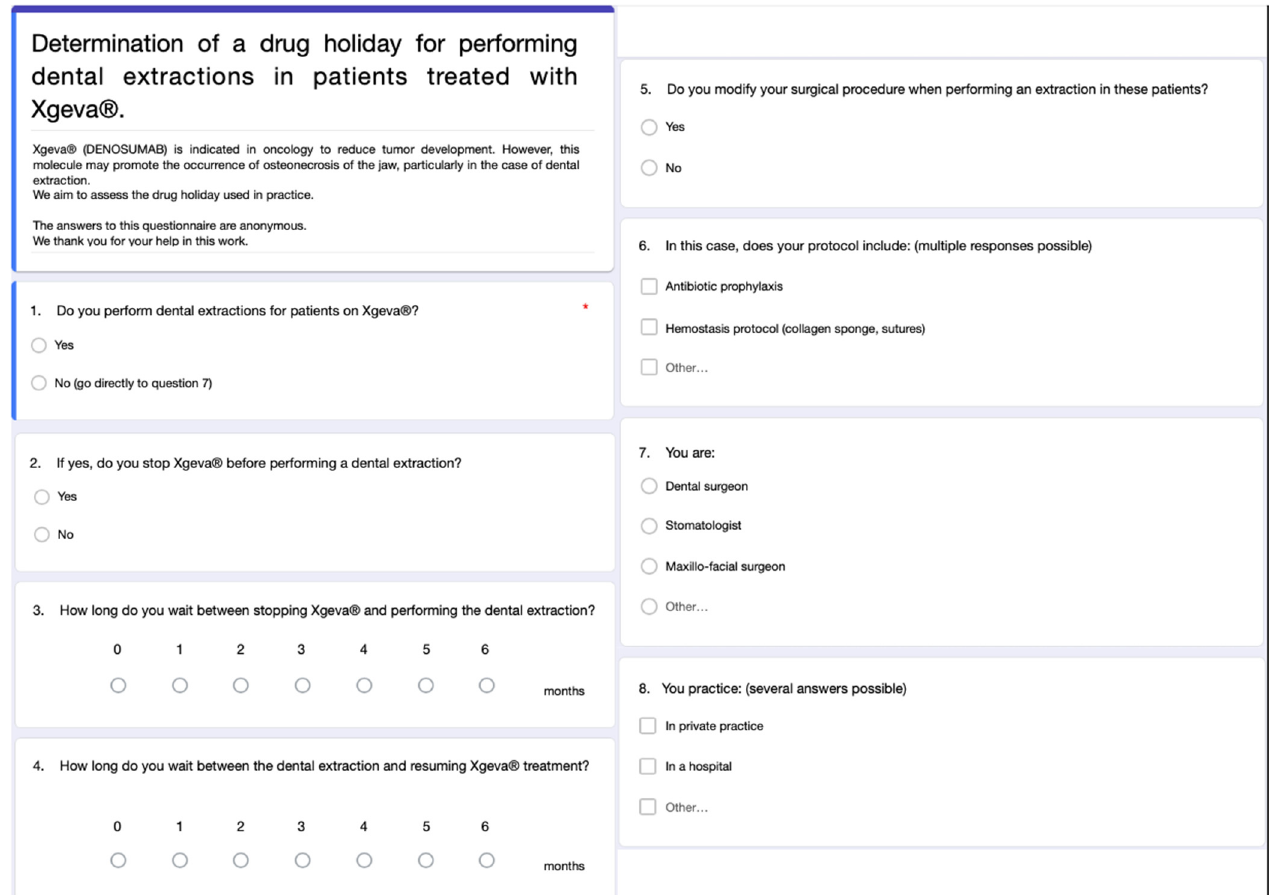
Fig. 1. Questionnaire: 8 questions on Google